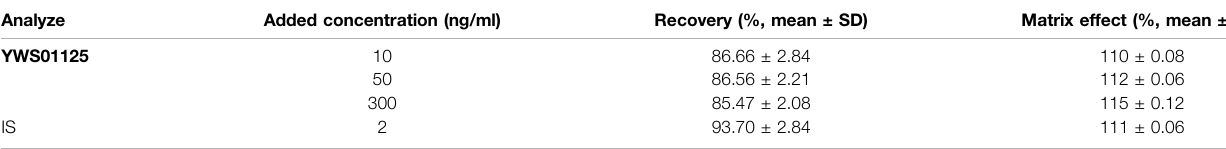
TABLE 2 | The mean extraction recoveries and matrix effect of YWS01125 and IS in the mouse plasma (n = 6). Analyze